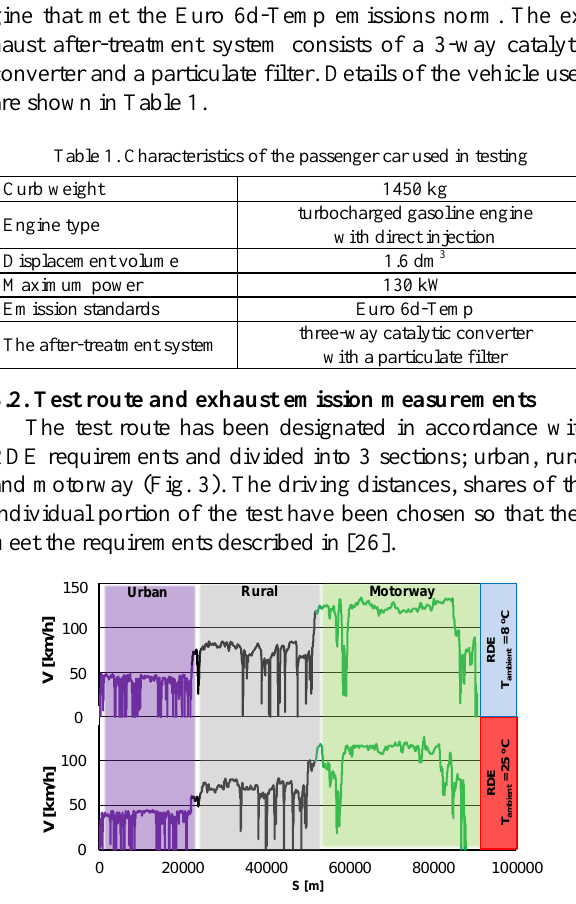
Fig. 3. Vehicle speed profiles in both RDE test drives